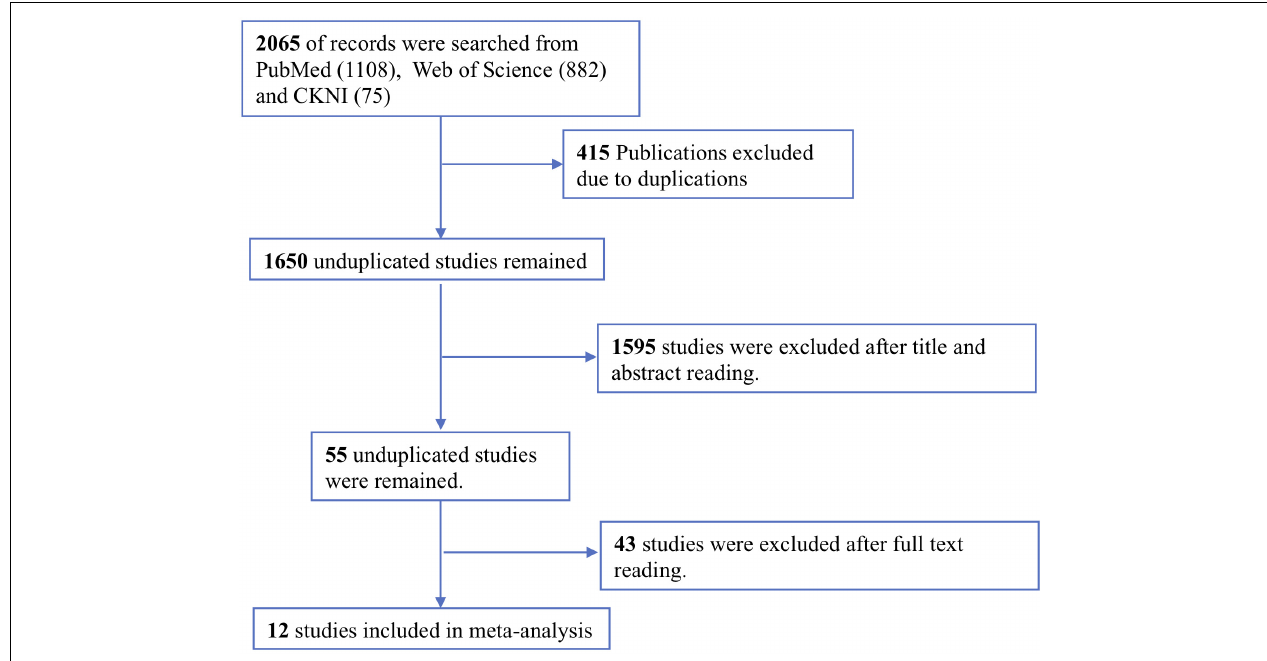
FIGURE 1 | Flowchart of the literature search and screening processes.